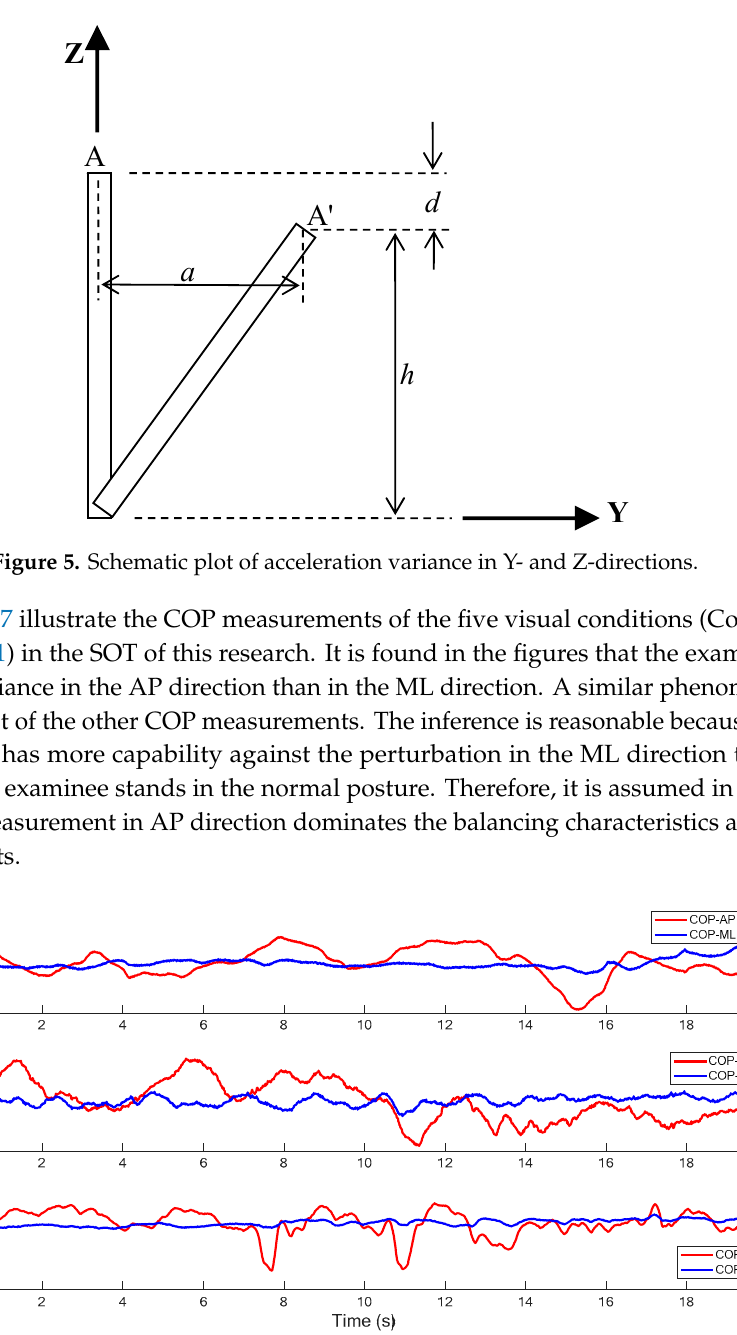
Figure 6. COP measurements in medial-lateral (ML) and anterior-posterior (AP) direction under Conditions 1–3.